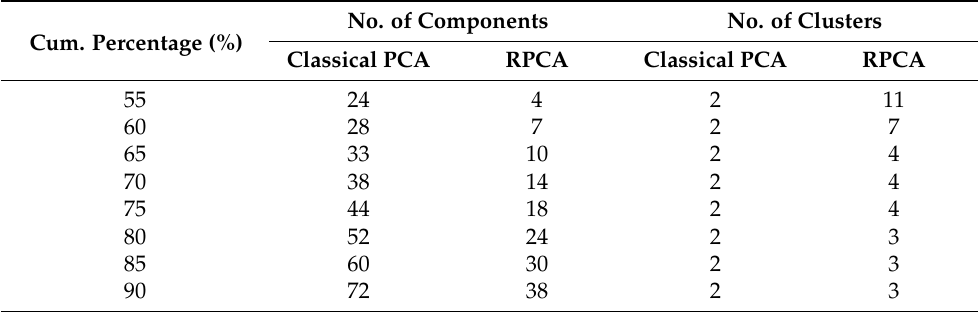
Table 7. Number of components and clusters obtained using classical PCA and RPCA based on simulation data.